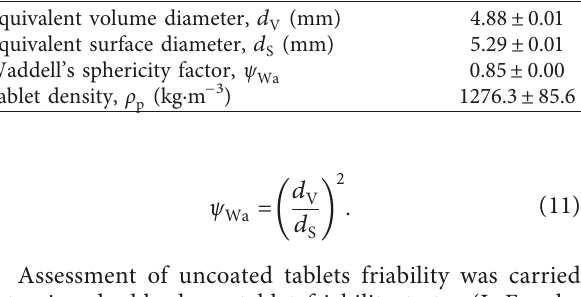
Table 2: Calculated characteristics of tablet cores.